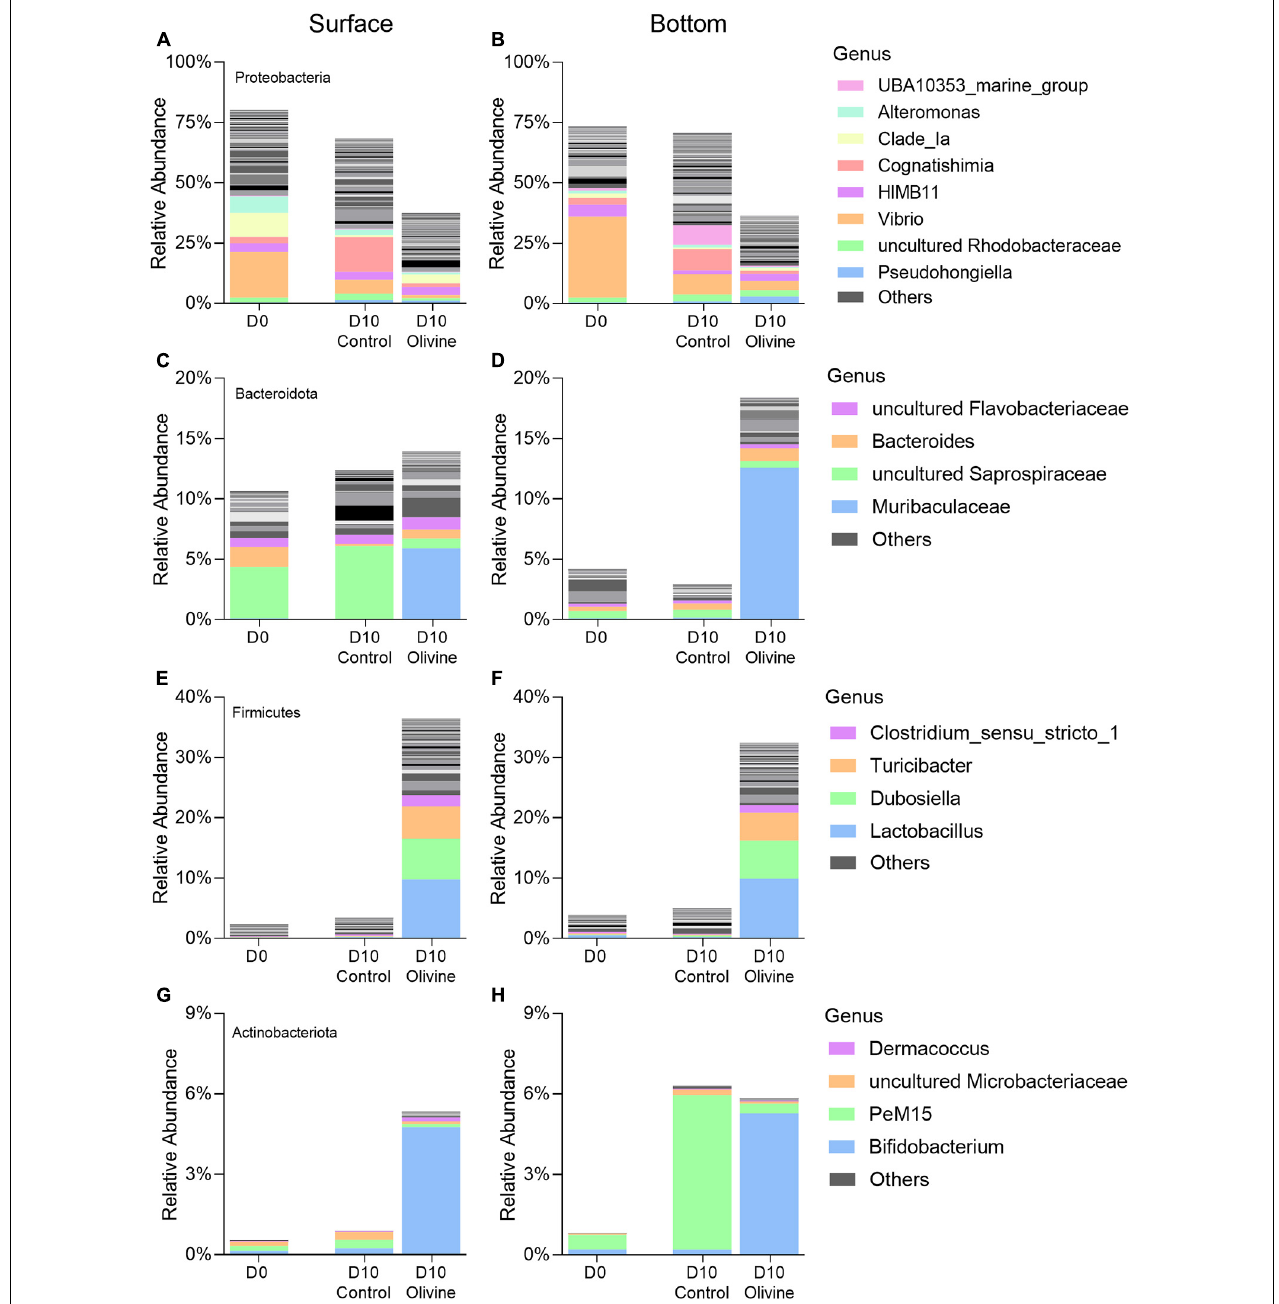
FIGURE 6 | Changes of averaged relative abundance ( N = 3) of particle-attached (PA, 3–20 µ m) bacterial communities that respond to olivine addition at the genera level, in initial and 10-day incubated seawater with or without olivine addition: (A,B) Proteobacteria ( Alphaproteobacteria and Gammaproteobacteria );